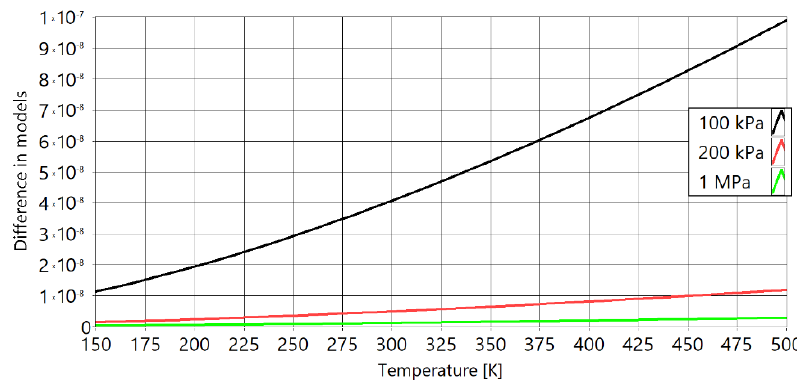
Figure 5. Error of the simplified model for different pressures for the imaginary part of the propagation constant Γ .